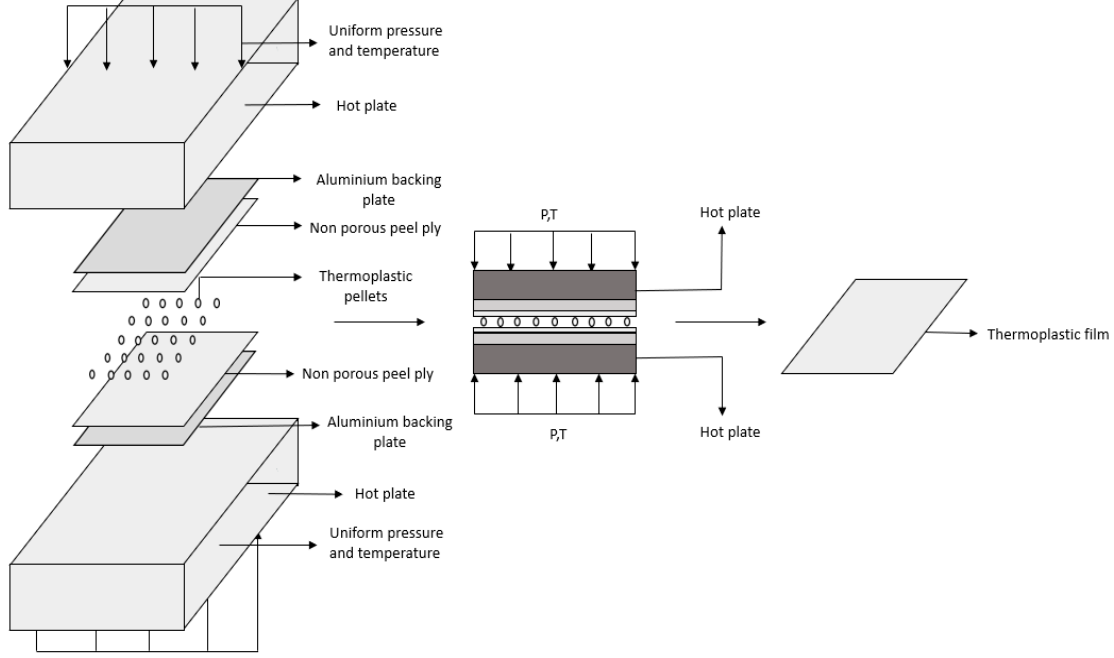
Figure 1. Thermoplastic film manufacturing schematic.